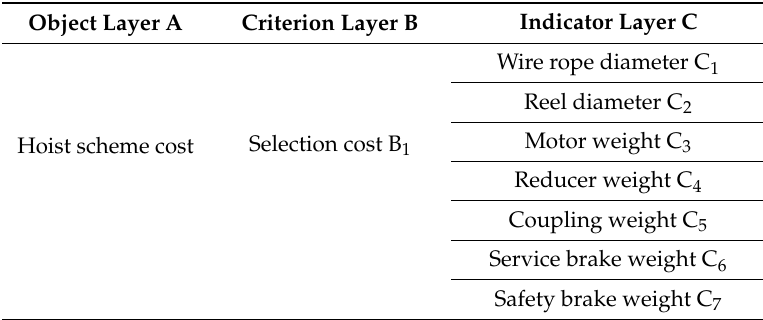
Table 6. Technical index system of scheme of